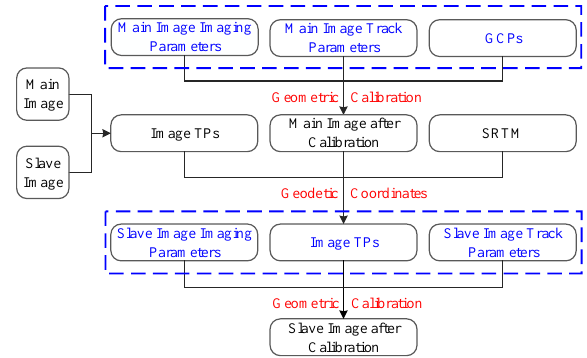
Figure 1. Flowchart of hybrid geometric